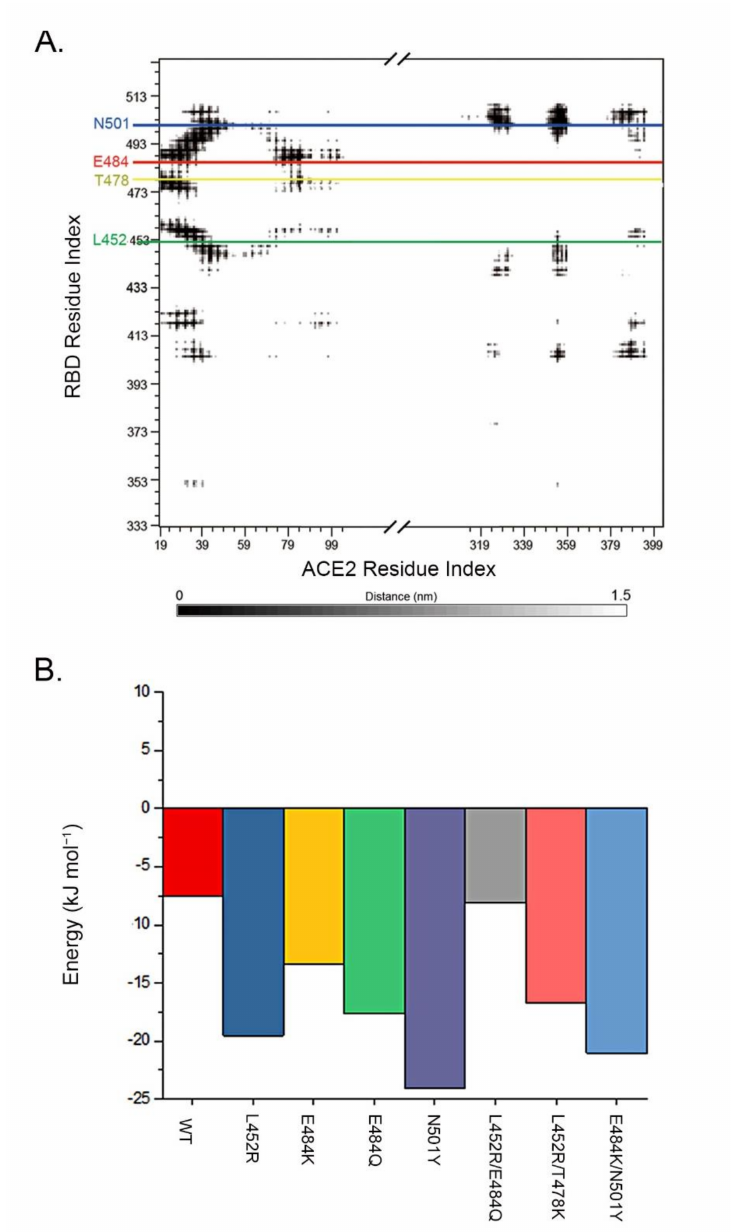
Figure 4. Free binding energy changes between mutated RBD and ACE2 receptor. ( A ). RBD and ACE2 residue interactions. Steps of 5 nm are represented by diminishing grey scale. The key